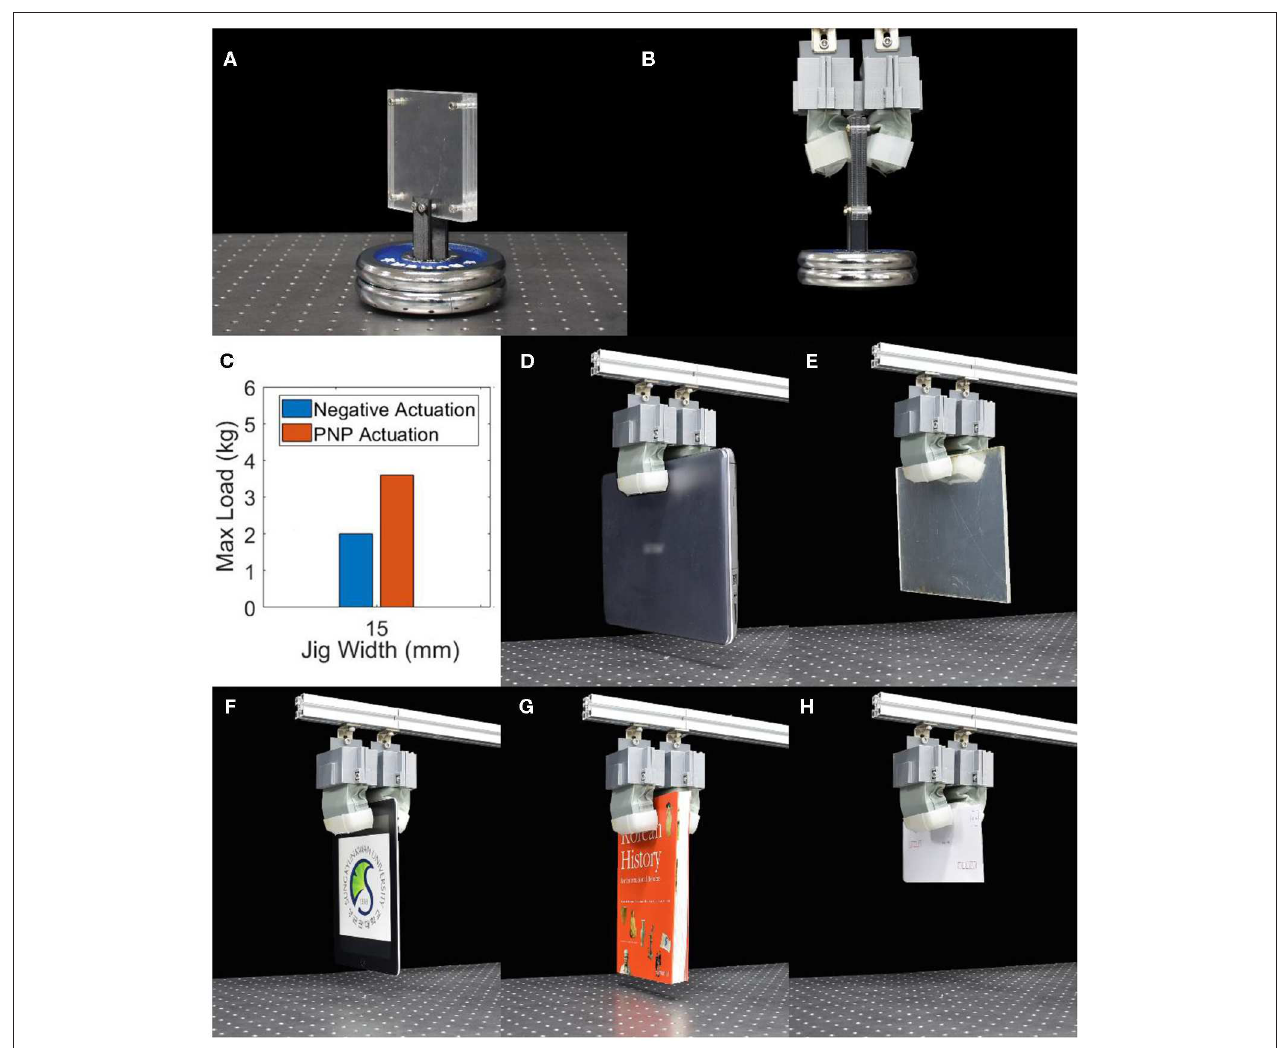
FIGURE 5 | (A) Jig for testing of soft pinch gripper, (B) soft pinching gripper grasping this jig, and (C) maximum load for the soft pinching gripper using PNP actuation and negative pressure actuation. The soft pinching gripper grasping (D) a notebook (1.85kg), (E) an acrylic plate (0.40kg), (F) an electronic tablet (0.66kg), (G) a book (0.78kg), and (H) an envelope